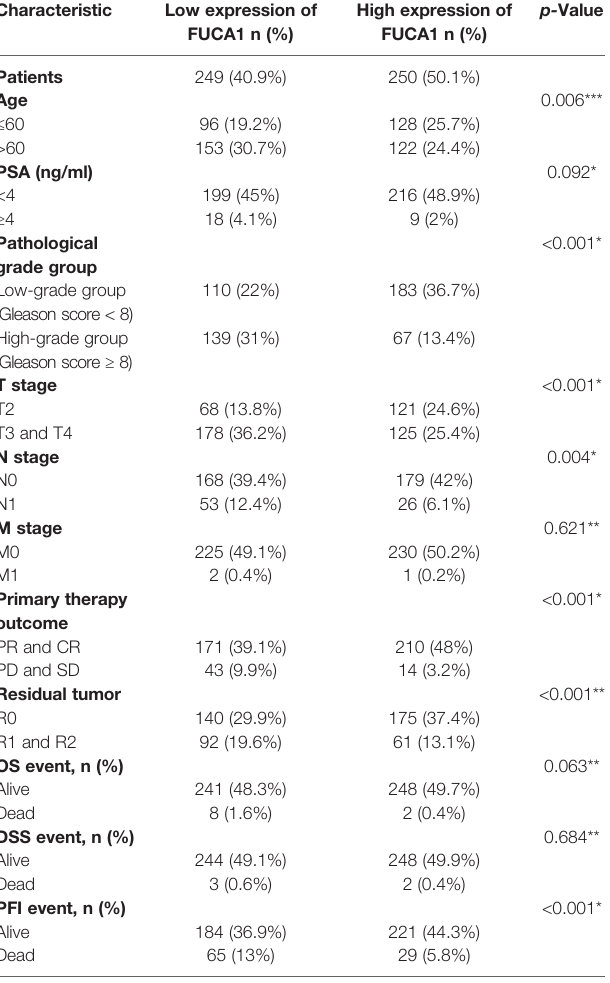
TABLE 3 | Correlations between FUCA1 expression and clinicopathological parameters of PCa patients. Characteristic Low expression of FUCA1 n (%)